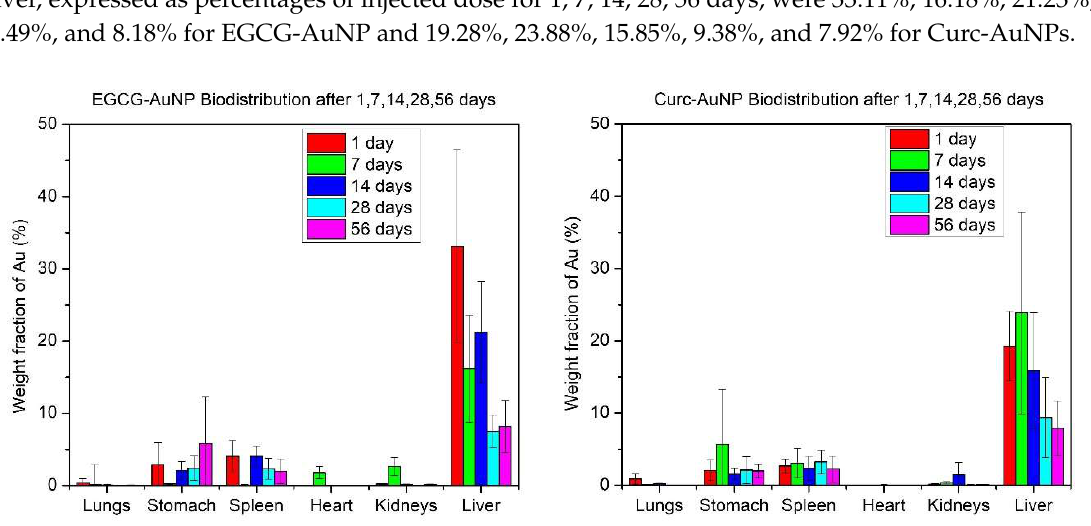
Figure 6. Weight fractions of injected AuNP dose found in select organs after acid digestion.